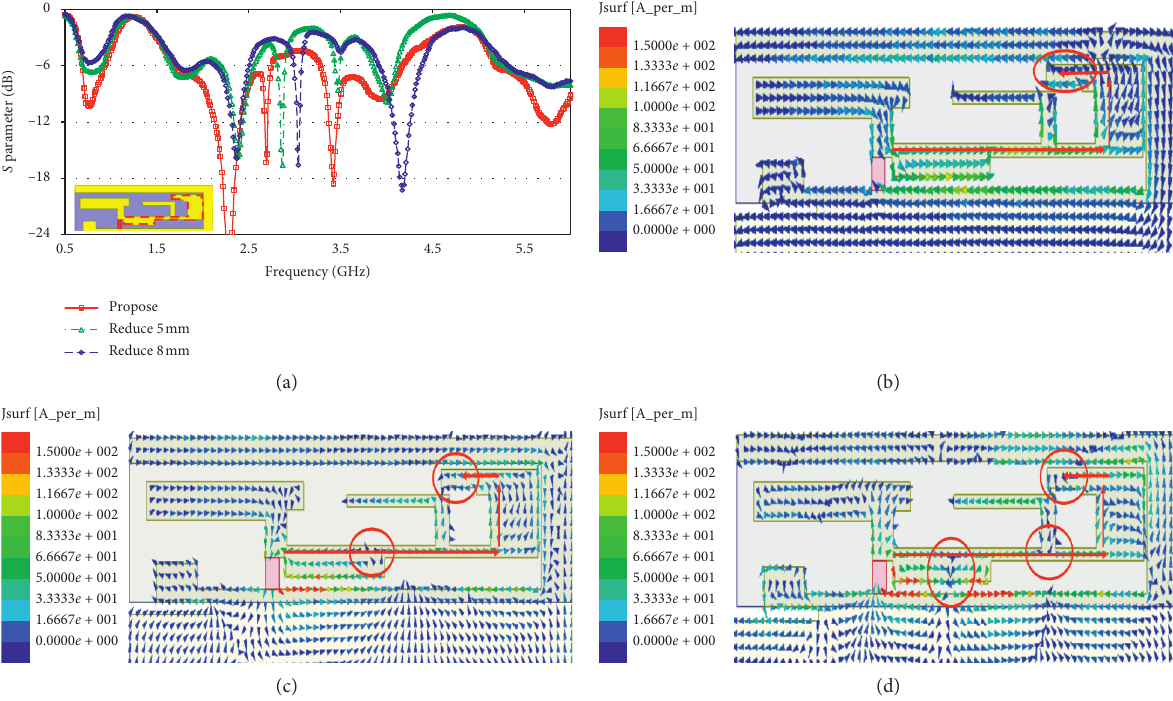
Figure 5: (a) S 11 values derived from the simulation considering different lengths of the right-side direct-fed arm of the developed antenna; current distribution of the direct-fed dipole at (b) 0.85, (c) 2.69, and (d) 4 GHz.